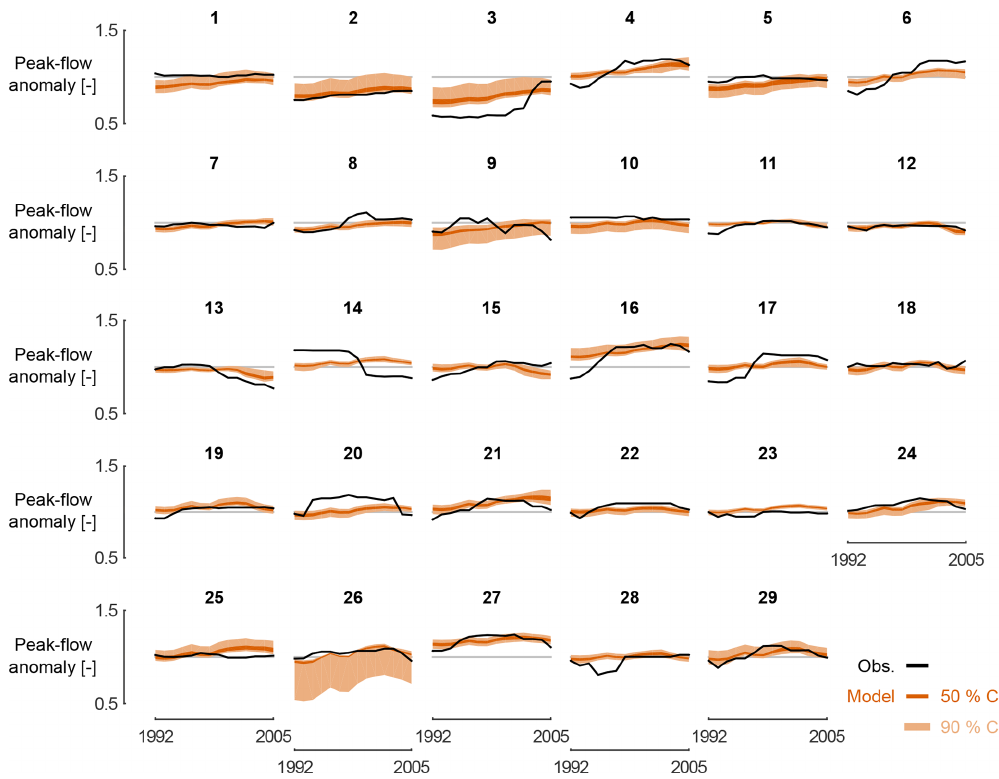
Figure 3. Regression model combining catchment characteristics, climate variability and land cover changes for explaining streamflow